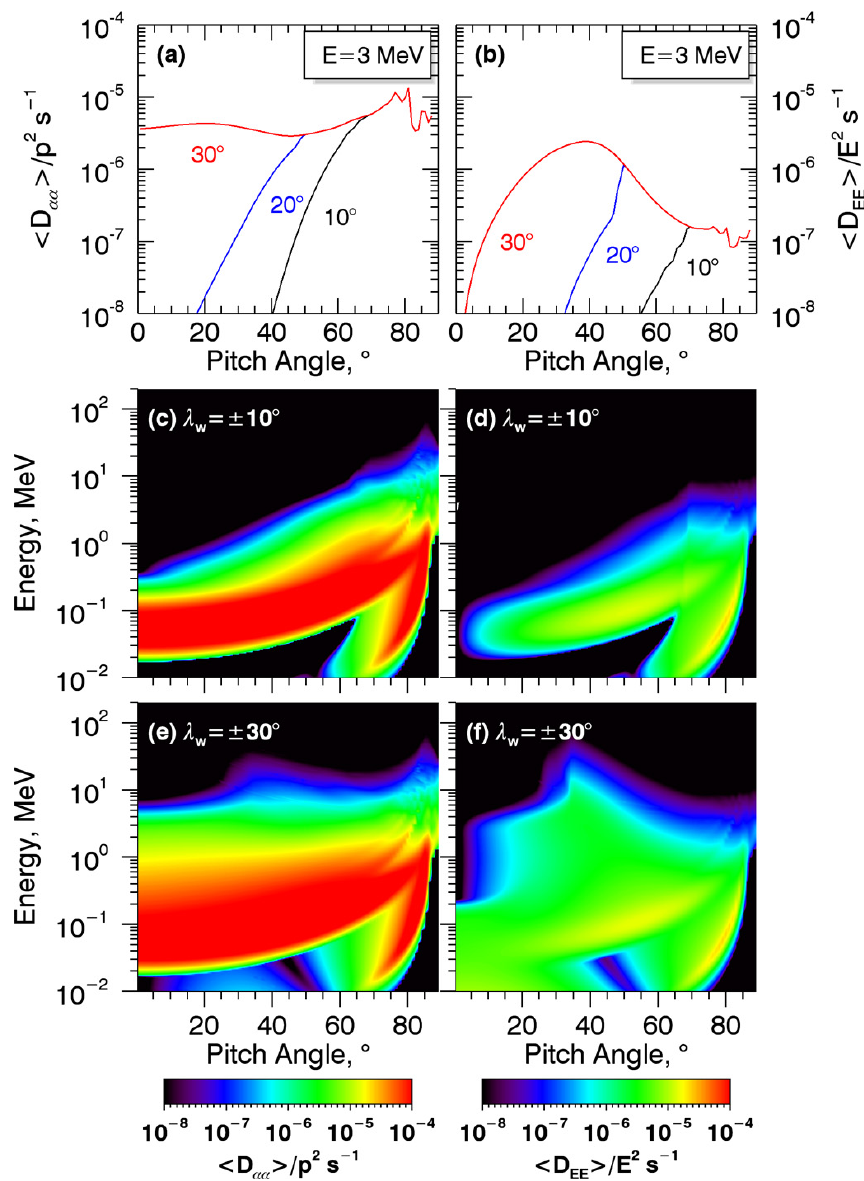
Fig. 3. Pitch angle and energy diffusion coefficients at L = 10 produced with chorus waves of constant intensity as a function of latitude and for different latitude ranges; left column: (a) shows < D αα > /p 2 at 3MeV, (c) variation of < D αα > /p 2 with energy for λ w = ± 10 ◦ and (e) same for λ w = ± 30 ◦ . Right column ( b , d and f ): same but for < D EE > /E 2